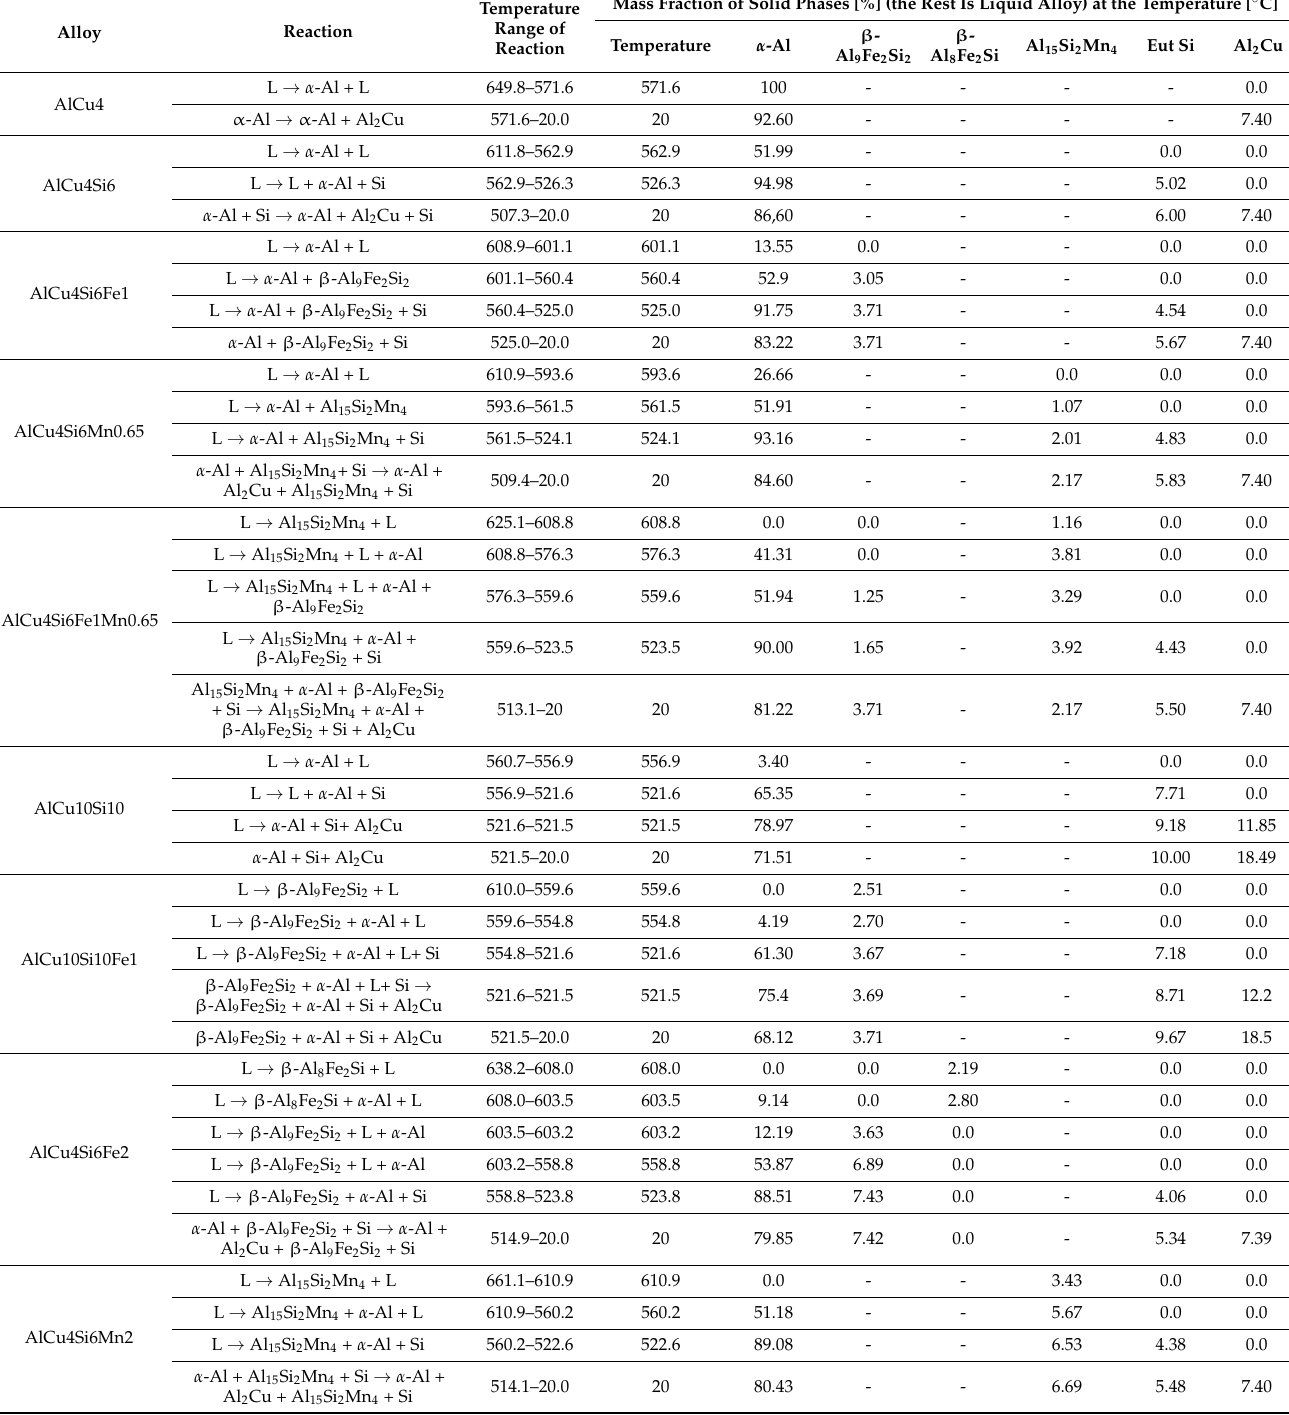
Table 2. Precipitation sequence in studied AlCu